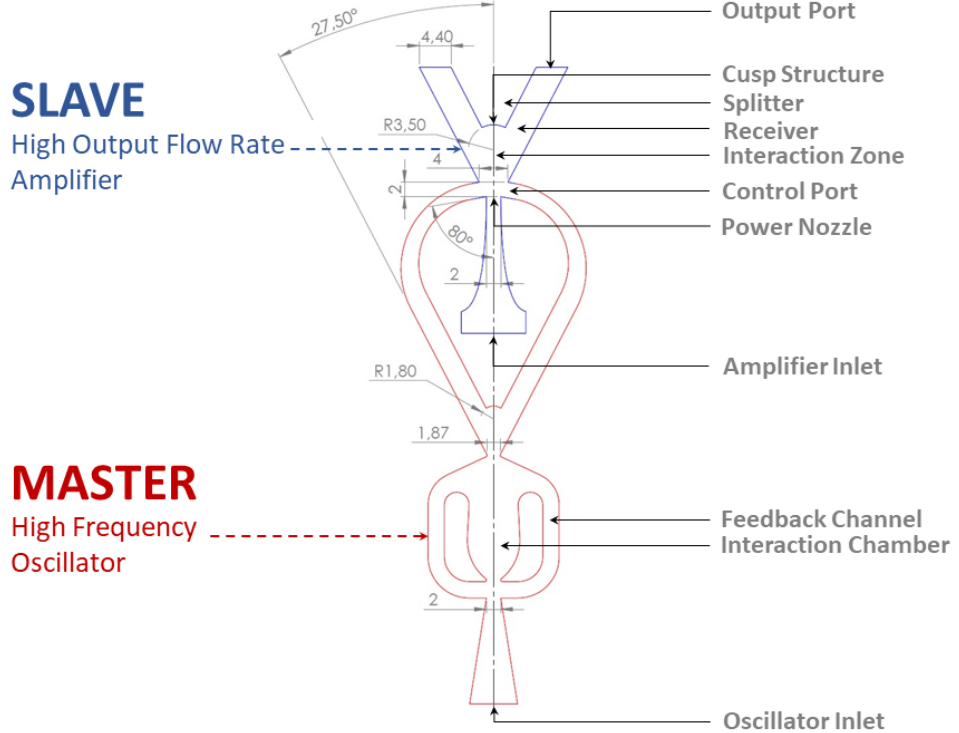
Figure 2. Design of the actuator based on the master–slave concept. The high-frequency oscillator, as the master, provides frequency information to the high-flow output of the amplifier, which acts as a